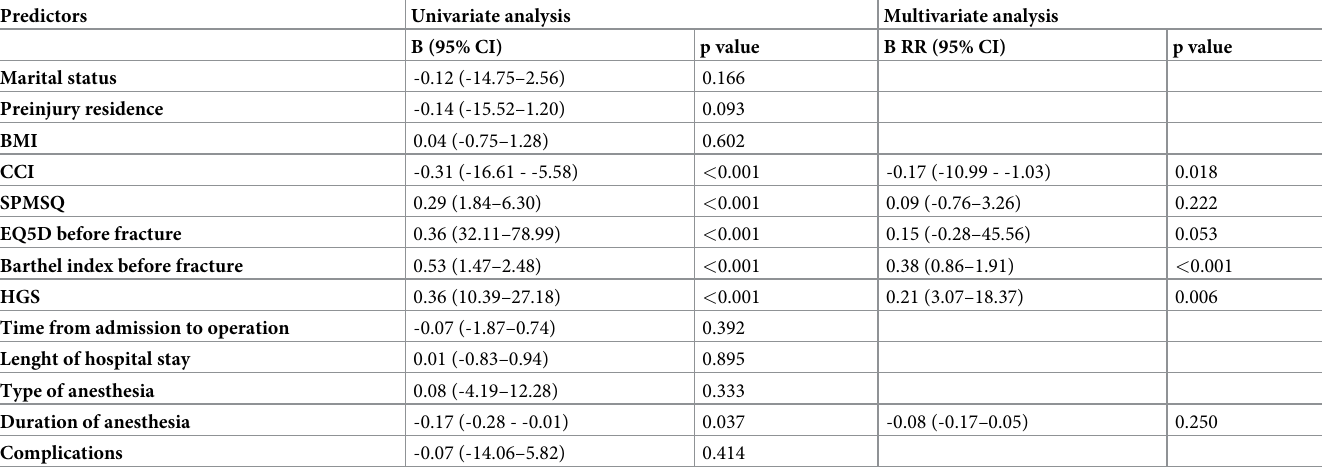
Table 3. Univariate and multivariate analysis for variables significantly associated with Barthel index scores 6 months after